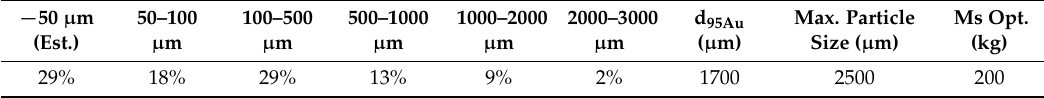
Table 21. Percentage gold particle distribution (by mass) for 20.5 g/t Au HGZ mineralisation.